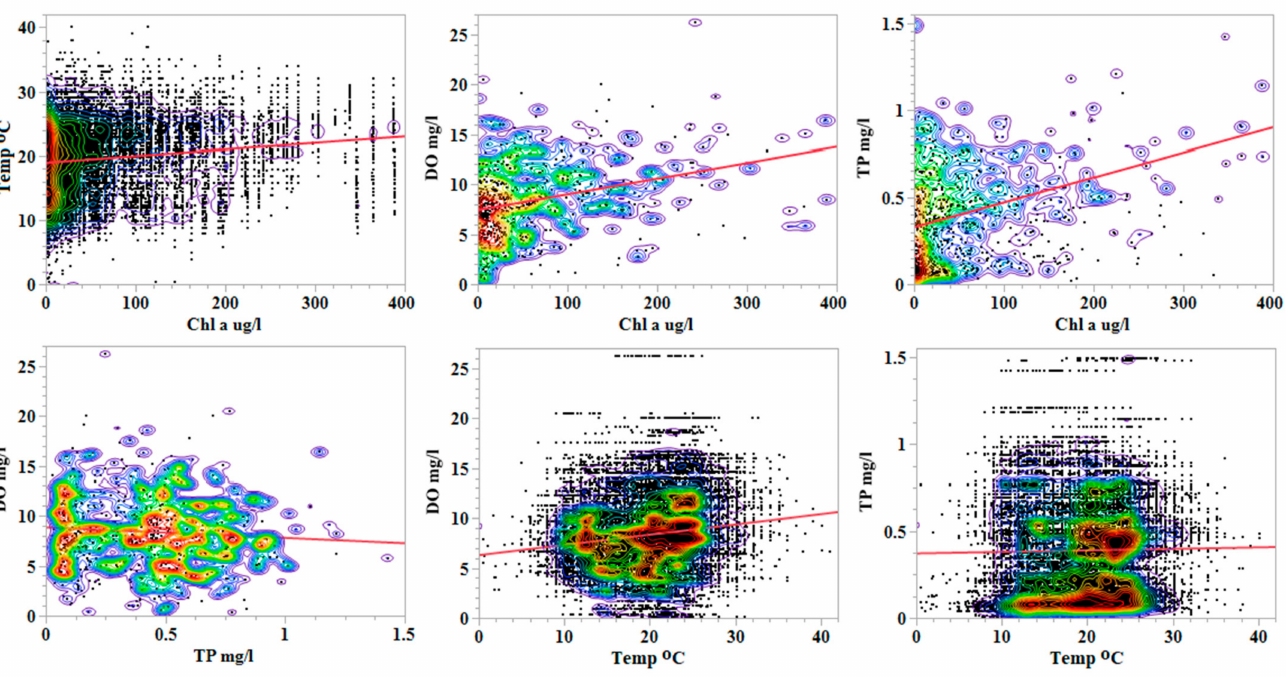
Figure 5. Scatter plots between the various water quality parameters; DWS. Regression analysis between satellite-based and in-situ chlorophyll-a data show a strong correlation with an R 2 = 0.86 and RMSE of 5.56 µ g/L (Figure 6). This demonstrates the applicability of global OC model to effectively retrieve chlorophyll-a in large productive open waters such as the Hartbeespoort Dam, where productivity levels are high. The OC model was used to predict chlorophyll-a level for 2020, where in situ data are not available.